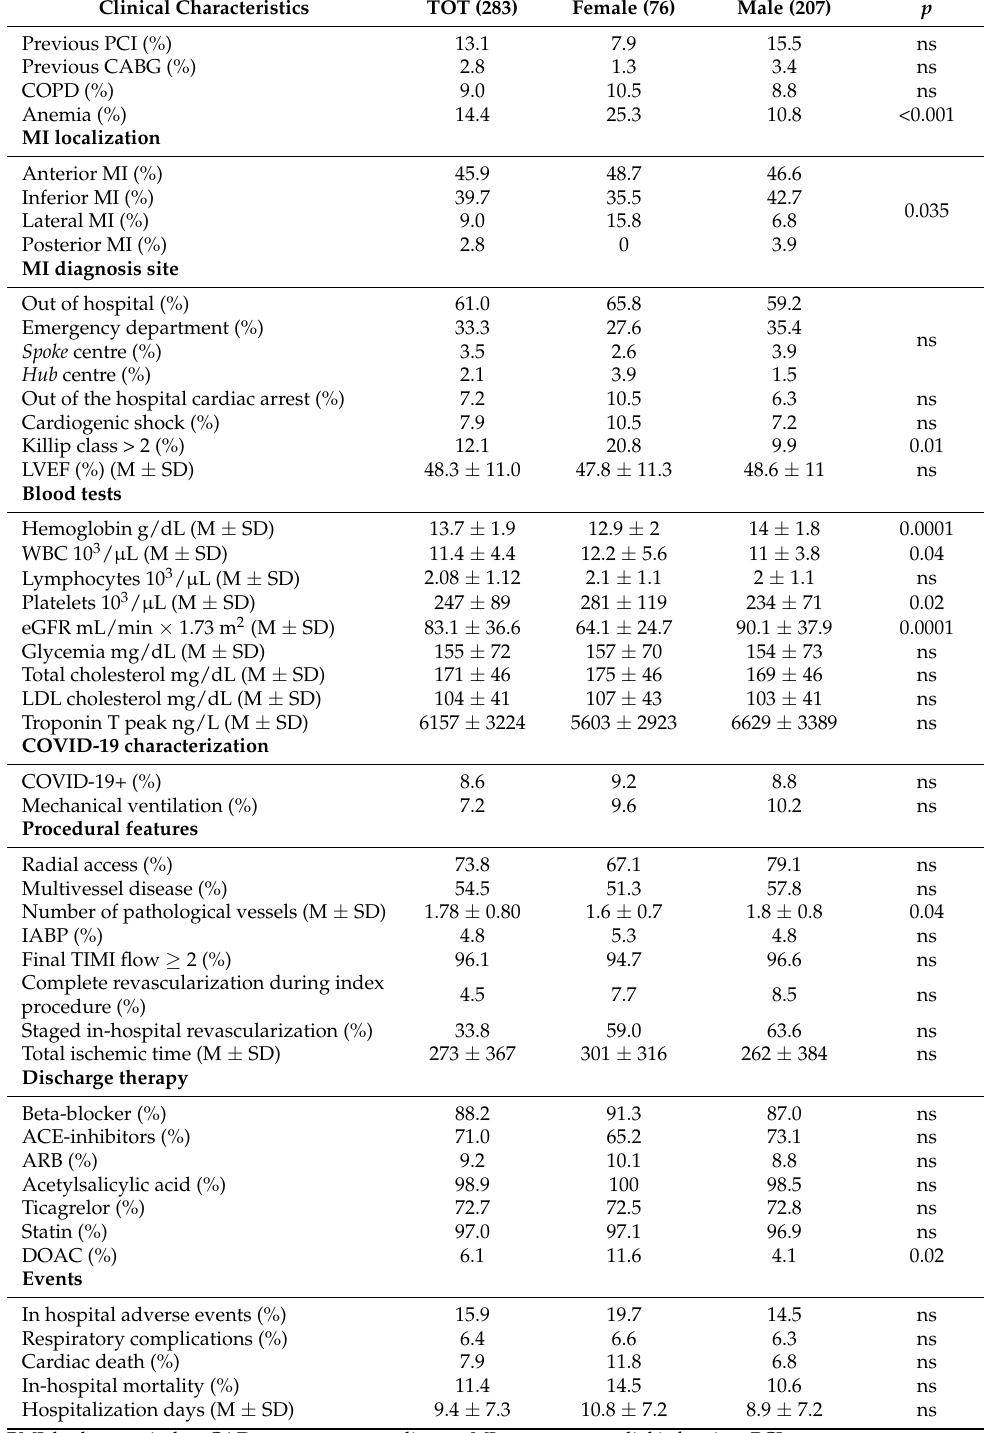
BMI: body mass index; CAD: coronary artery disease; MI: acute myocardial infarction; PCI: percutaneous coronary intervention; CABG: coronary artery bypass grafting; COPD: chronic obstructive pulmonary disease; LVEF: left ventricle ejection fraction; WBC: white blood cells; LDL: low density lipoprotein; IABP: intra-aortic balloon pump; TIMI: thrombolysis in myocardial infarction; ACE: angiotensin converting enzyme; ARB angiotensin receptors blockers; DOAC: direct oral